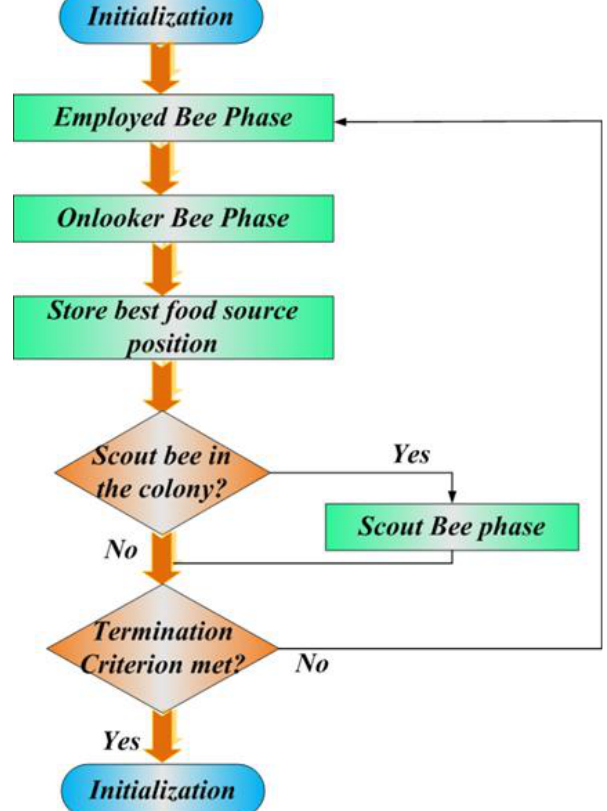
Figure 3. Flowchart of ABC algorithm.